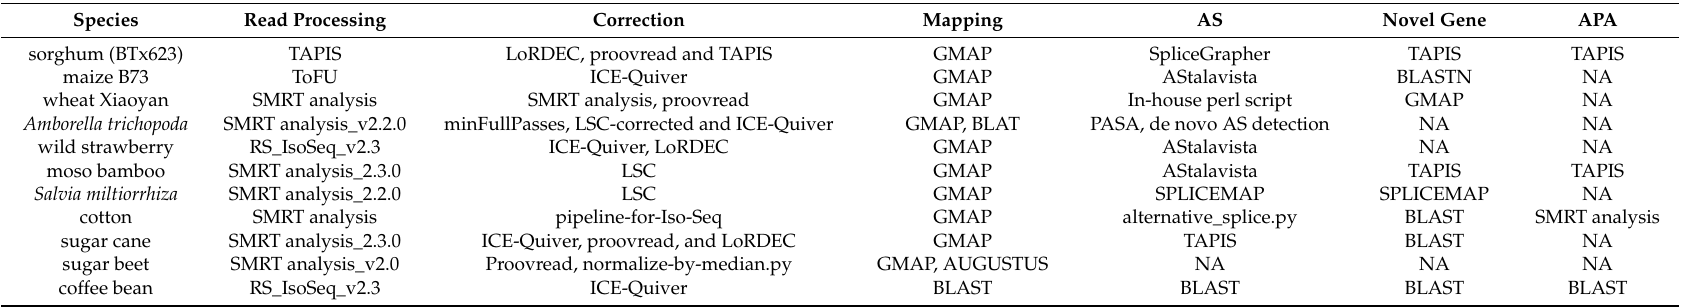
Table 4. Bioinformatic programs applied in plant Iso-Seq